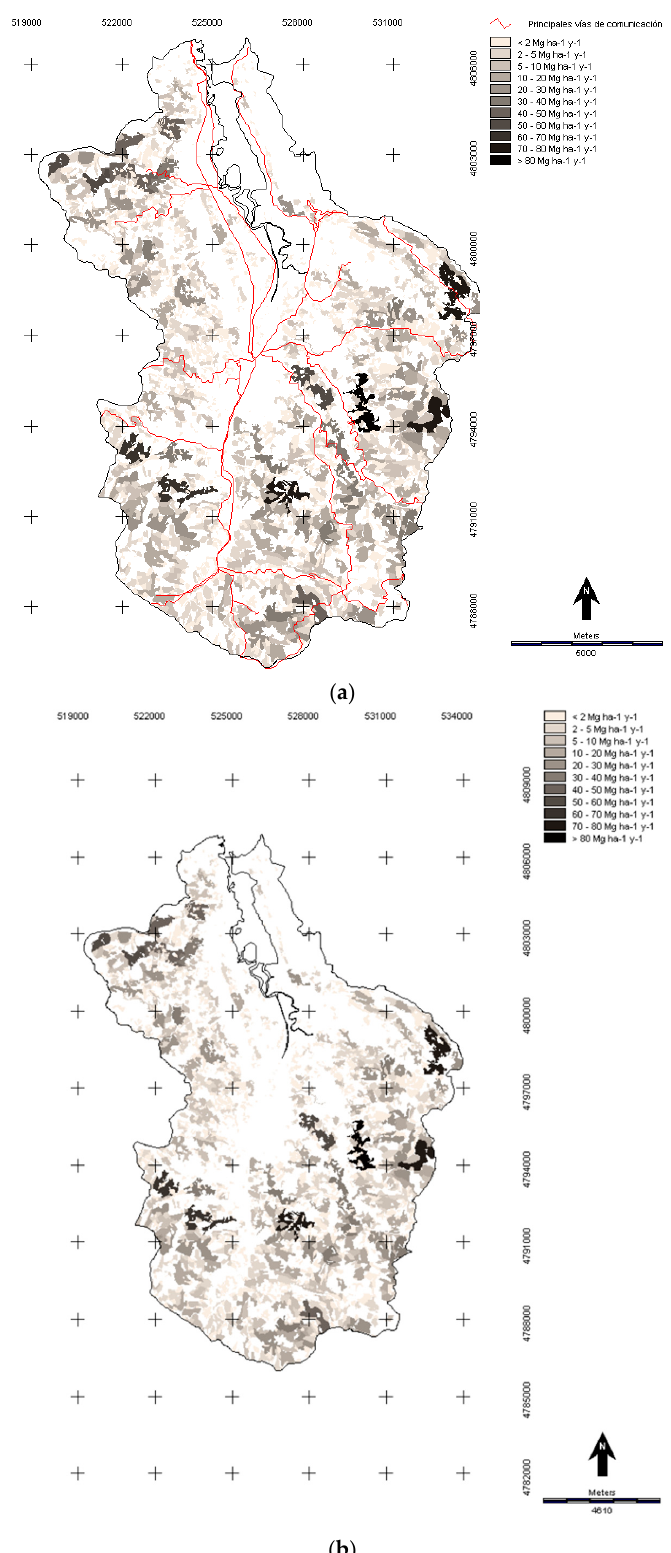
Figure 7. Residual biomass. ( a ) usable; ( b ) available.